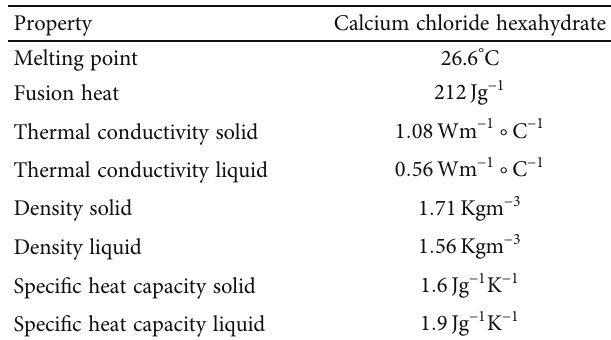
Figure 1: Complete work diagram. Table 1: Thermophysical properties of calcium chloride hexahydrate